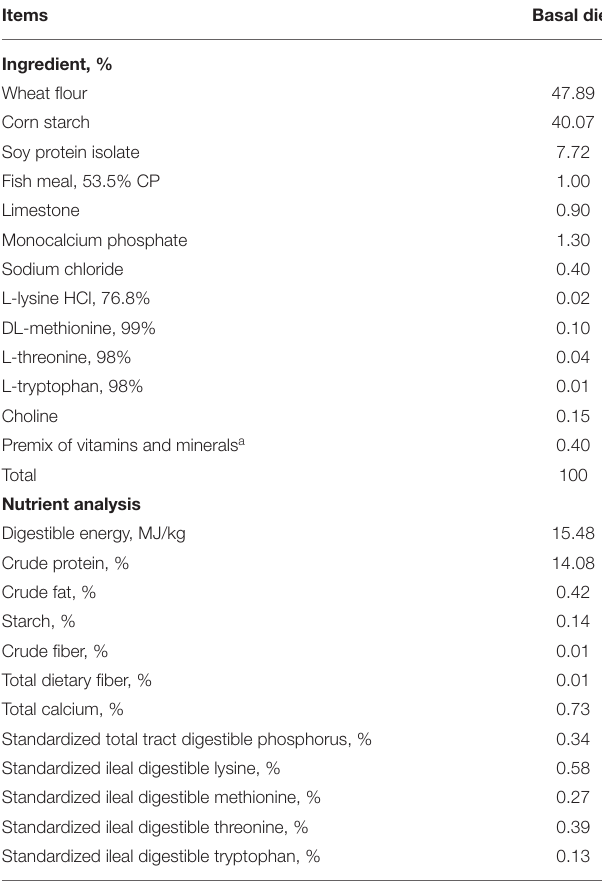
TABLE 1 | Composition and calculated analysis of semi-purified basal